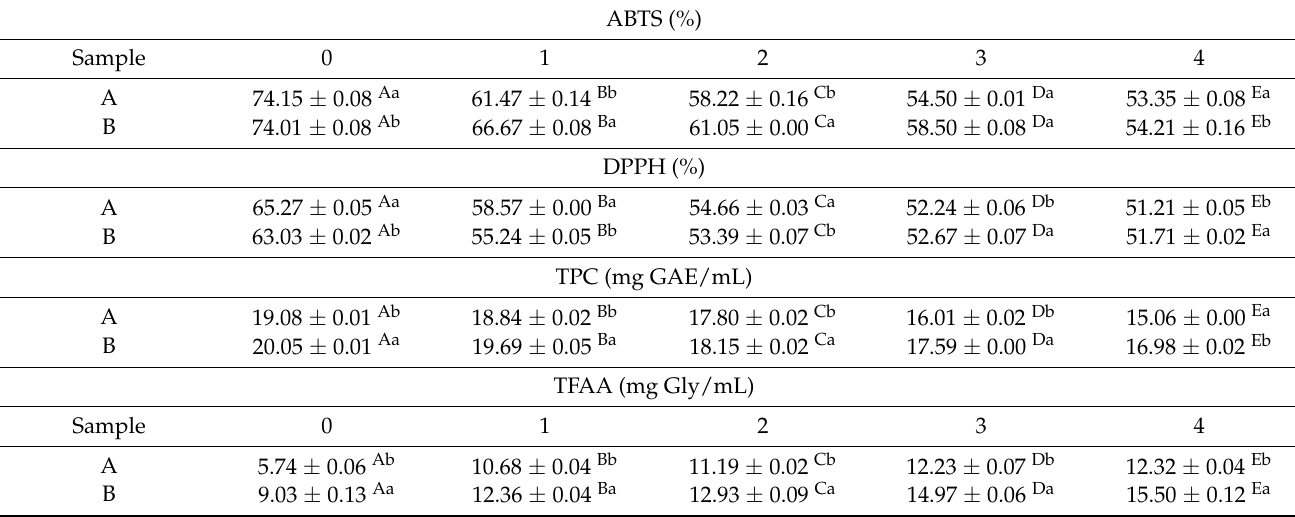
Values are means ± standard deviation of triplicate determinations. Means with different lowercase letters in the same column are significantly different at p < 0.05. Means with different uppercase letters in the same raw are significantly different at p < 0.05. The highest TPC was observed for initial samples (A: 19.08 ± 0.01 mg GAE/mL and B: 20.05 ± 0.01 mg GAE/mL). After four weeks sample A exhibited lower